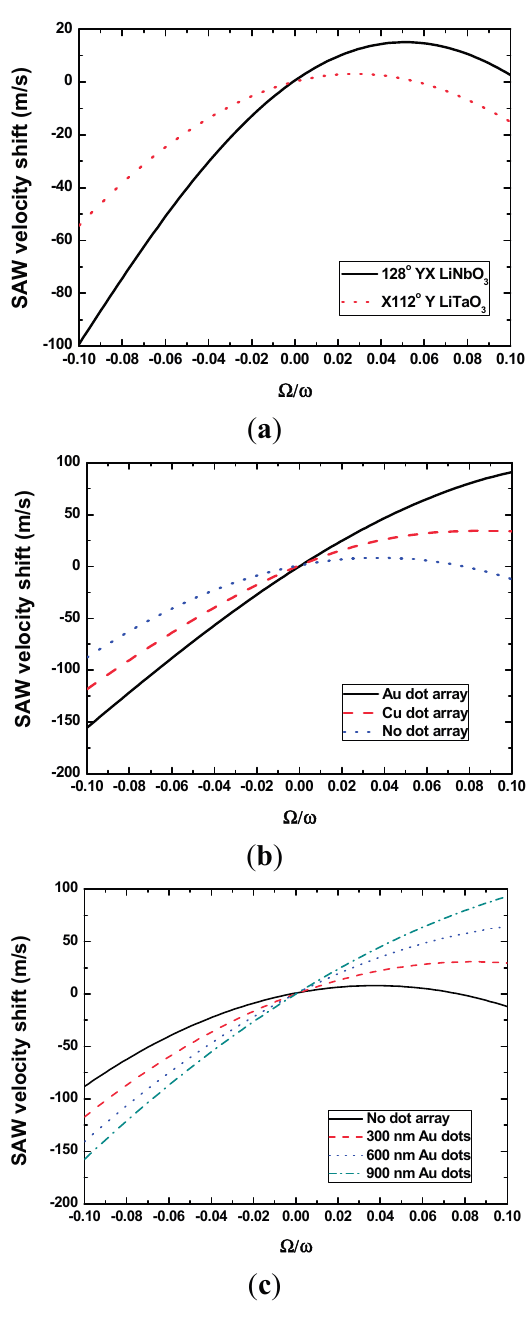
Figure 4. Calculated effects from the piezoelectric substrate ( a ), metallic dots ( b ), and geometry of dots ( c